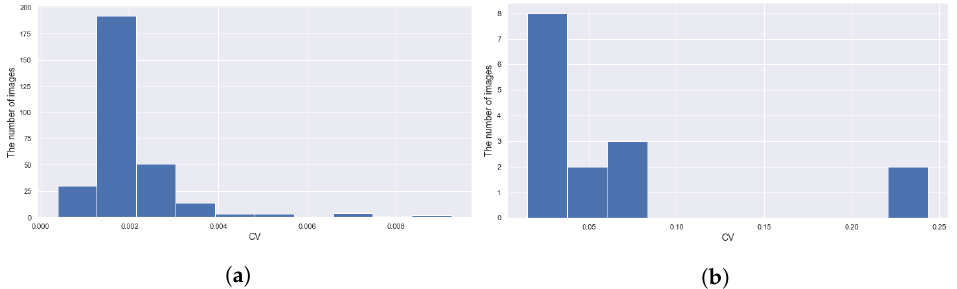
Figure 17. The histograms of CVs of the 11 measurements for individual images (Figure 12). ( a ) The 300 smaller CVs, which we consider as normal. ( b ) The 15 largest CVs, which we treat as the evidence for outliers.